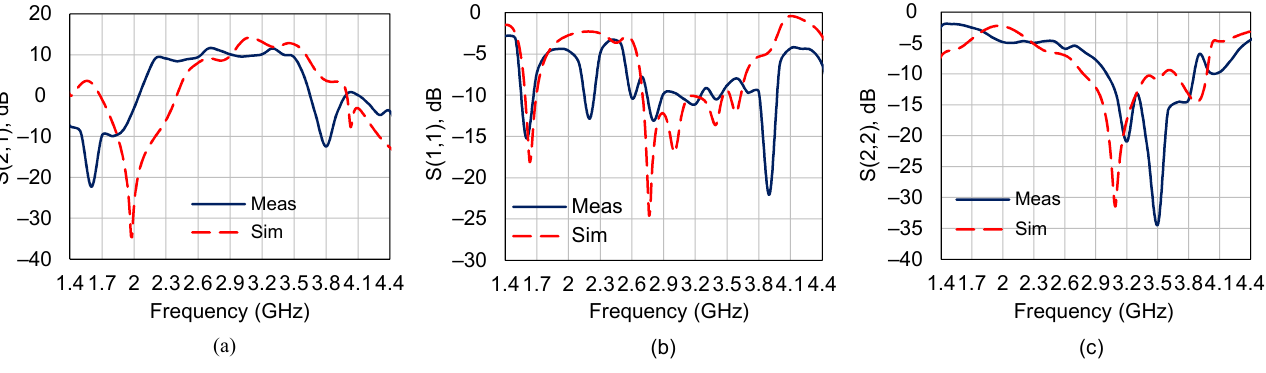
Figure 14. Simulated (dashed) and measured (solid) scattering parameters of the proposed DPA ( a ) S ( 2,1 ) , ( b ) S ( 1,1 ) , and ( c ) S ( 2,2 ) .